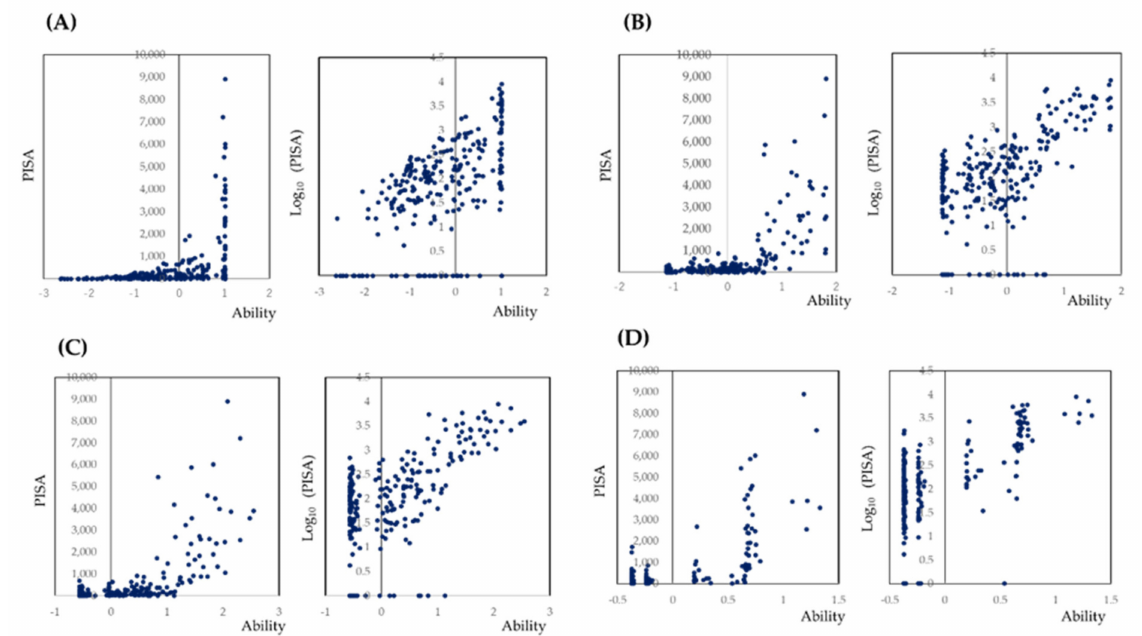
Figure 2. Scatter plots of PISA against the maximum value of PD within each teeth. ( A – D ) shows the findings with cut-off points of 3, 4, 5, and 6 mm of PD within one tooth. When PISA was log 10 transformed, linear relationships were observed.